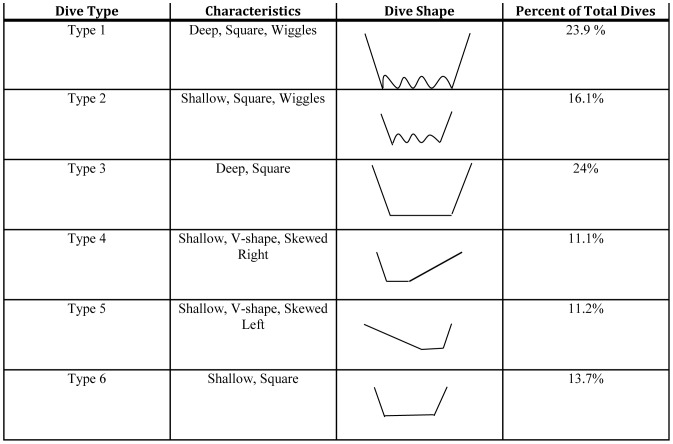
Dive shapes and general characteristics of harbor seal dives in the San Juan Islands.Deep dives are those with a maximum depth ≥20 m, shallow dives are <20 m.